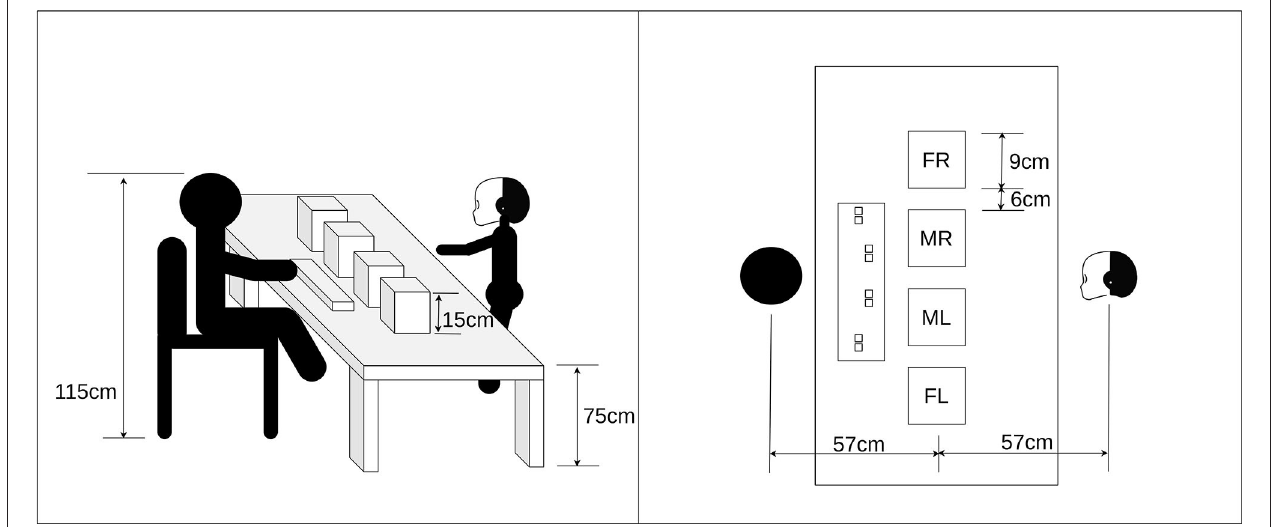
FIGURE 3 | Experiment setup showing the positioning of the robot and the participant. Also, the four stimulation boxes and their locations. Far left “FL,” Middle left “ML,” Middle right “MR,” and Far right